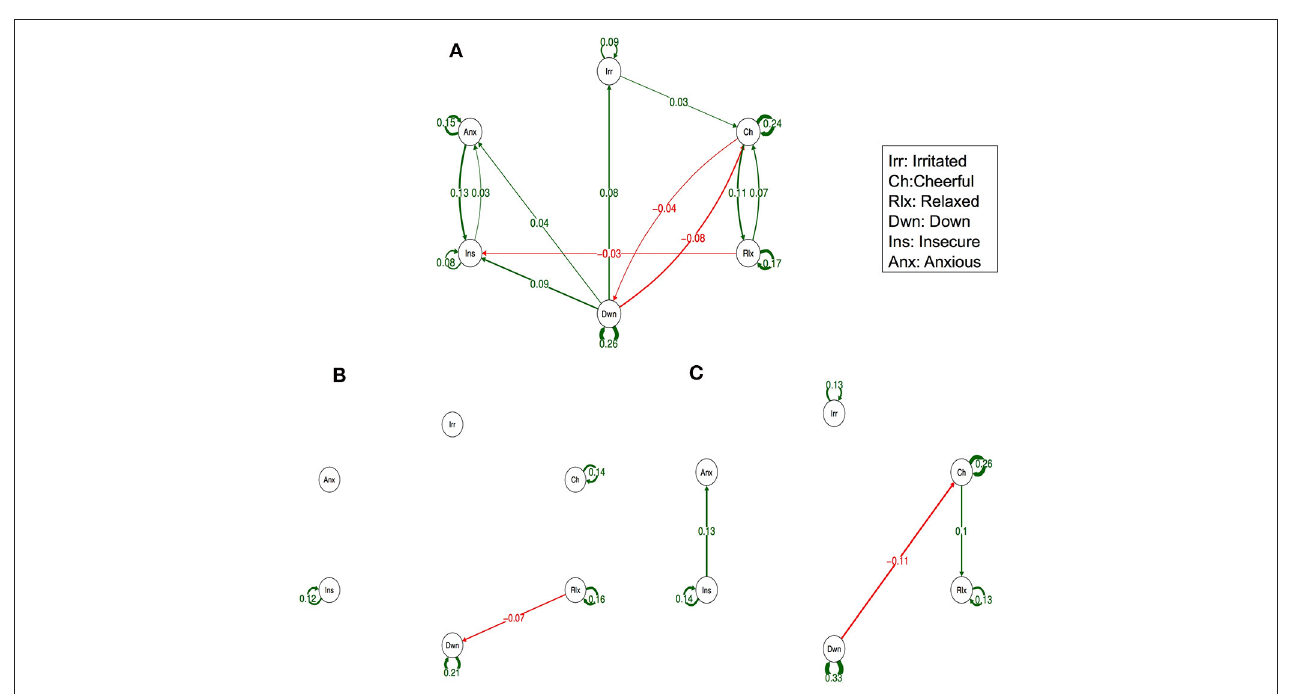
FIGURE 3 | Networks of momentary affective mental states (AMS) in participants with low (A) , intermediate (B) , and high genetic liability for psychopathology (C) . In this figure, the arrows represent associations over time, i.e., the B coefficient expressing the effect size of the predictive associations. For example, in the low genetic liability network, there is an arrow from “relaxed” to “cheerful,” meaning that “relaxed” at t − 1 predicts “cheerful” at t with a B coefficient of 0.07. Green arrows represent positive associations, and red arrows represent negative associations. The line width represents the strength of the association and is determined by the regression weights: the wider the line, the stronger the association (and vice versa). Only significant associations after Simes correction for multiple testing are displayed (alpha is